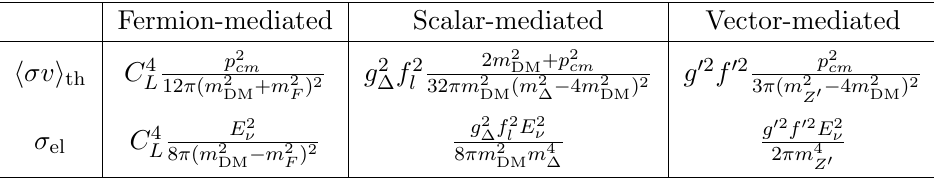
Table 1. Thermally averaged DM annihilation cross-section and the cross-section for neutrino-DM elastic scattering for thermal